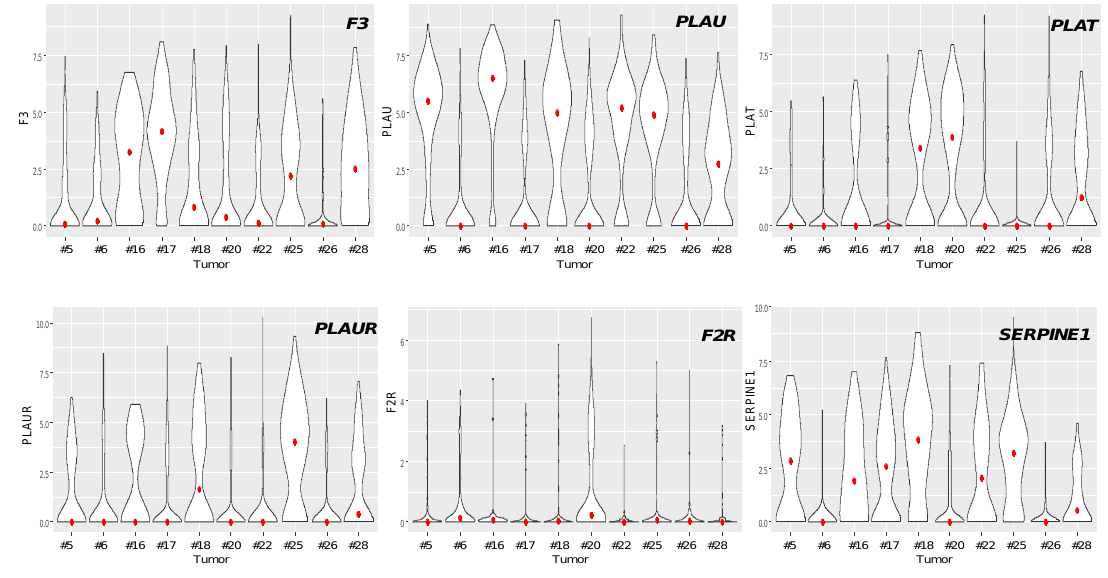
Figure 6. Intra-tumor heterogeneity of the coagulome of malignant cells from individual OSCC. Violin plots showing the expression of the core coagulome genes ( F3 , PLAU , PLAT , PLAUR , F2R and SERPINE1 ) in cancer cells from different OSCC tumors analyzed in GSE103322. Each individual tumor was identified according to the study by Puram et al. [28]. The red dots represent the median Fig. 7 value for the expression of each gene.